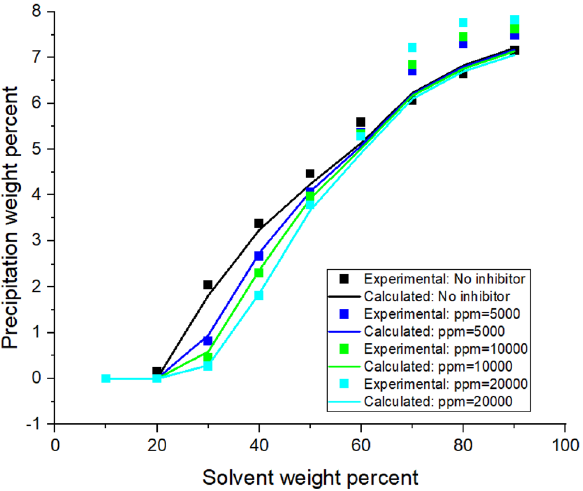
Figure 7. Asphaltene precipitation rate from the oil sample C in terms of solvent ratio with inhibitor (a = 2.17 × 10 6 and b = 15.06).